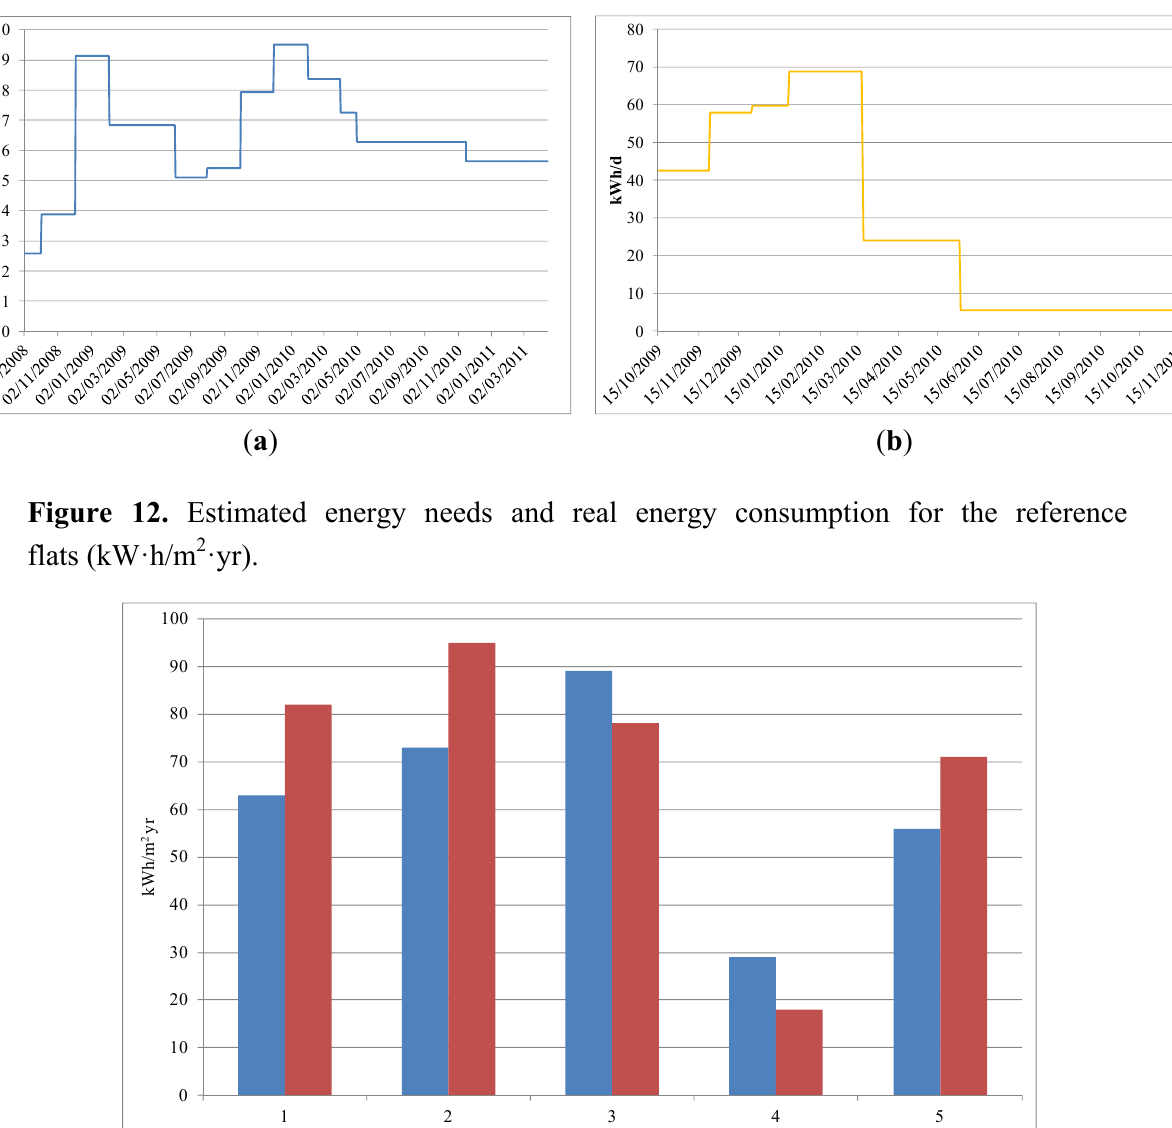
Figure 11. Daily average consumption of ( a ) electricity and ( b ) natural gas estimated for a reference flat of the Building 2, for the period 2008–2011.